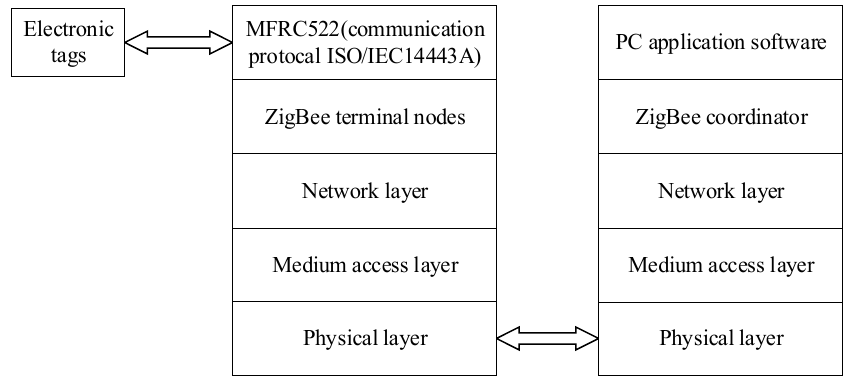
Figure 7. System communication protocol architecture.